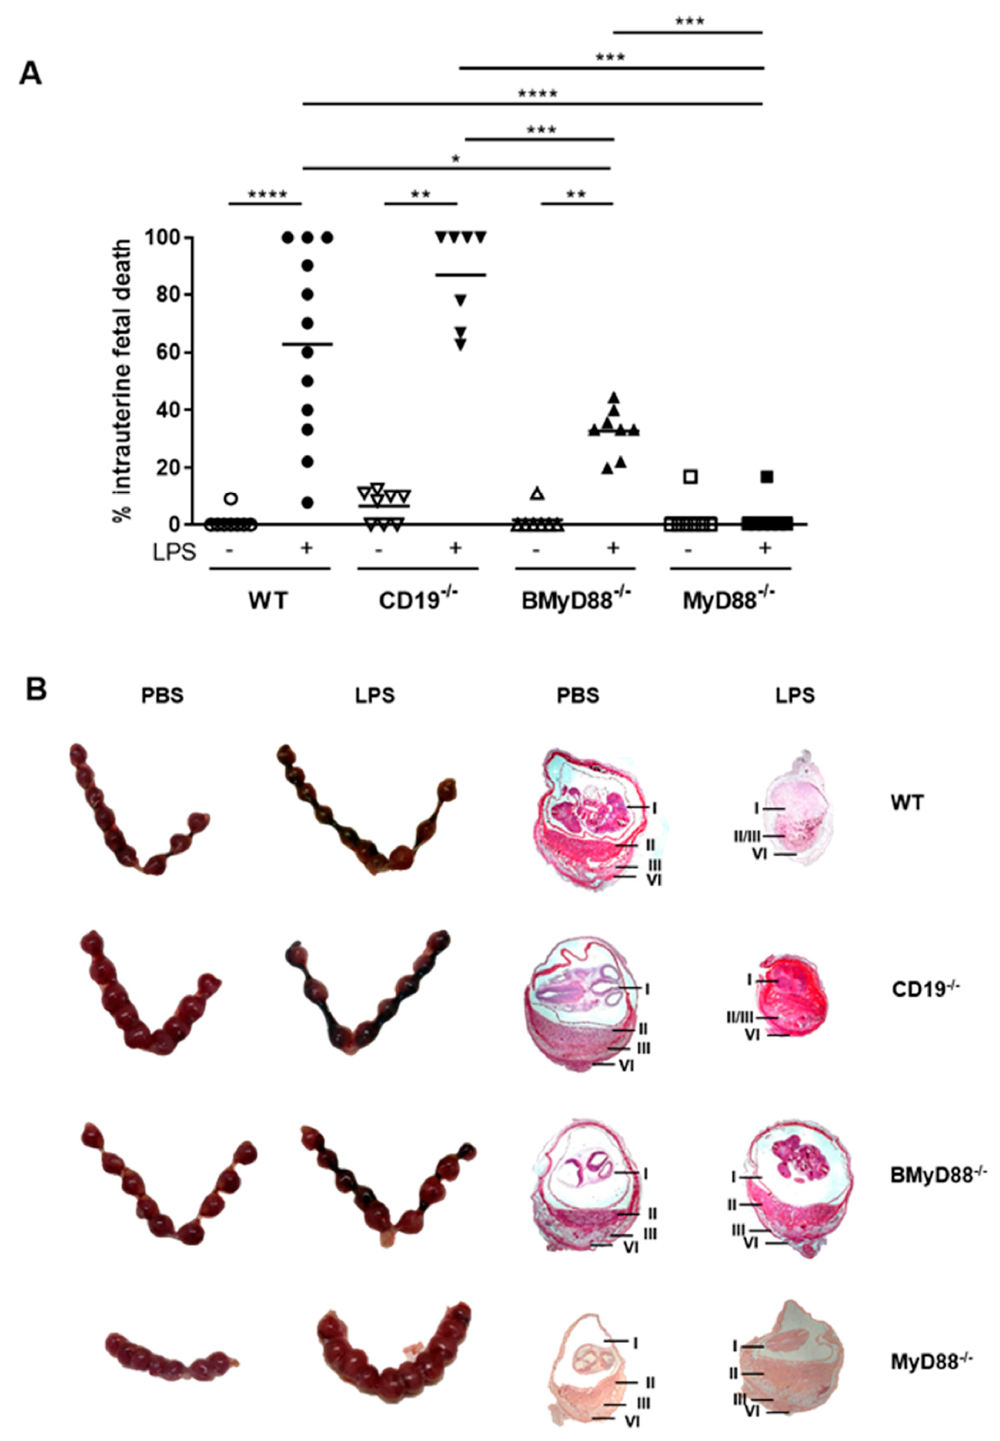
Figure 2. Fetuses from WT and CD19 -/- mice are more susceptible to LPS than those from BMyD88 -/- and MyD88 -/- mice. The rate of intrauterine fetal death was determined at 24 h after LPS or PBS injection in gestational day (gd) 10 pregnant WT, BMyD88 -/- , CD19 -/- and MyD88 -/- mice. The Kruskal–Wallis test and Mann–Whitney U test were used to analyze the data; N = 7–9 mice/group; * p < 0.05, ** p < 0.01, *** p < 0.001, **** p < 0.0001 ( A ). Representative images captured of the uteri and whole implantation sites ( B ), showing I (amniotic cavity; II (placenta); III (decidua basalis) and IV (mesometrial lymphoid aggregate of pregnancy). Shown are the mean